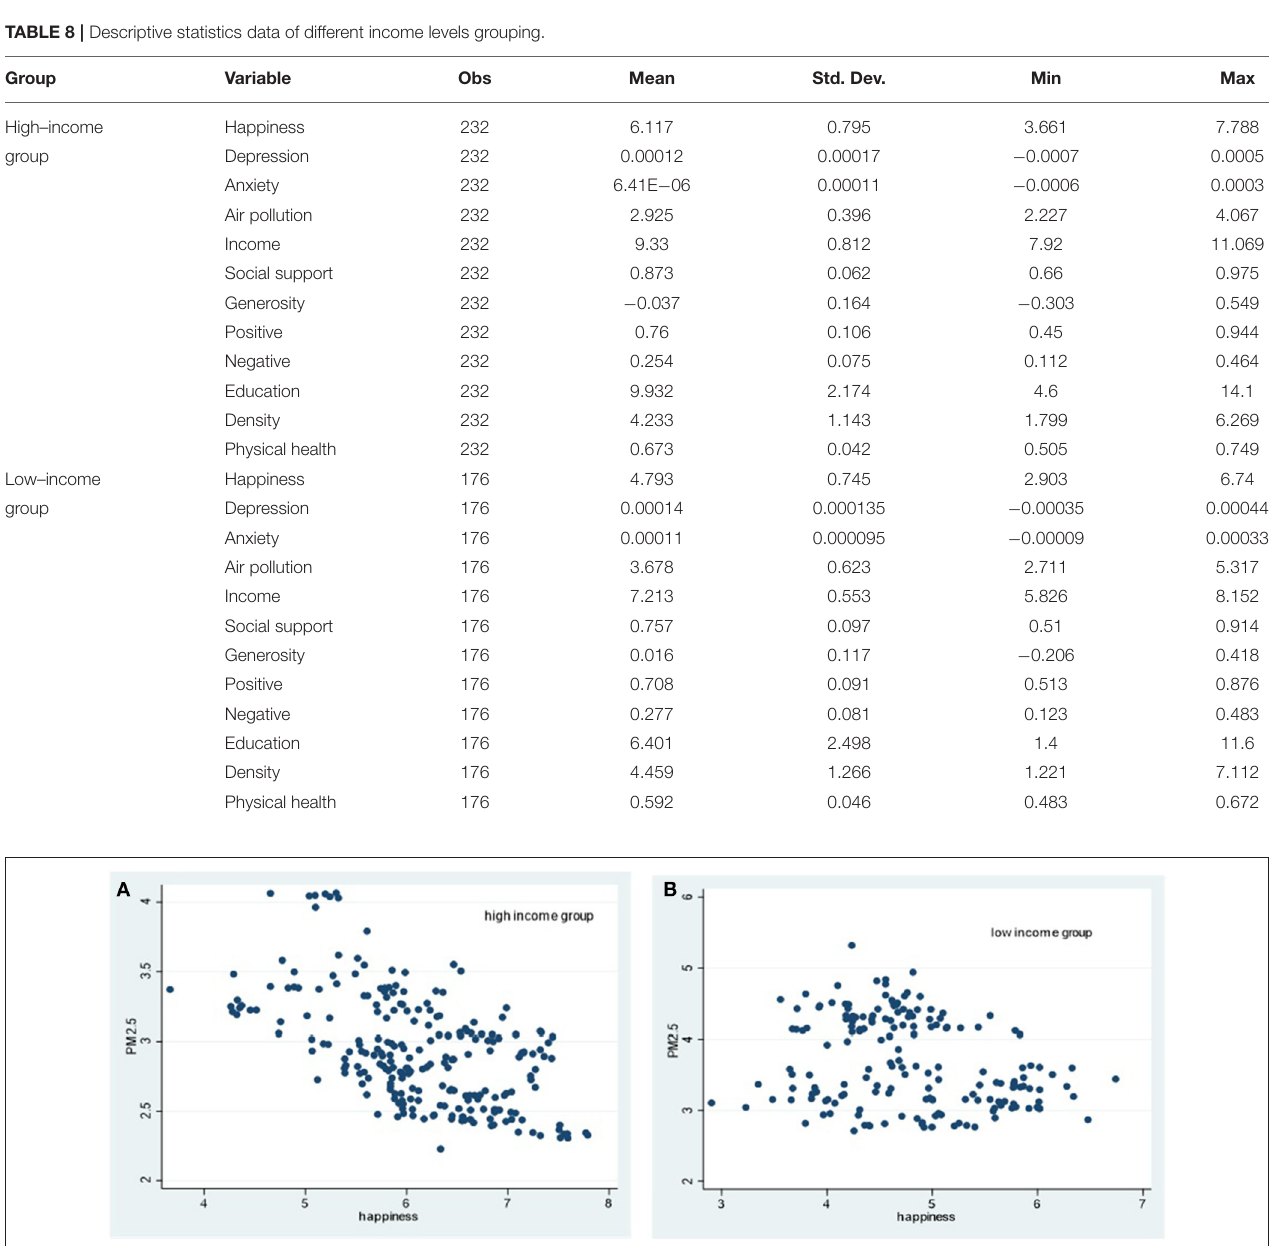
Methodology. The test uses MLE mediating effect model. First, based on the significant impact of air pollution on happiness only in high-income countries, hence only the sample of high-income countries is selected to test the intermediate effect of physical health. To test the intermediate effect of physical health on the effect of air pollution on depression and anxiety, the sample of influence on depression and anxiety in low-income